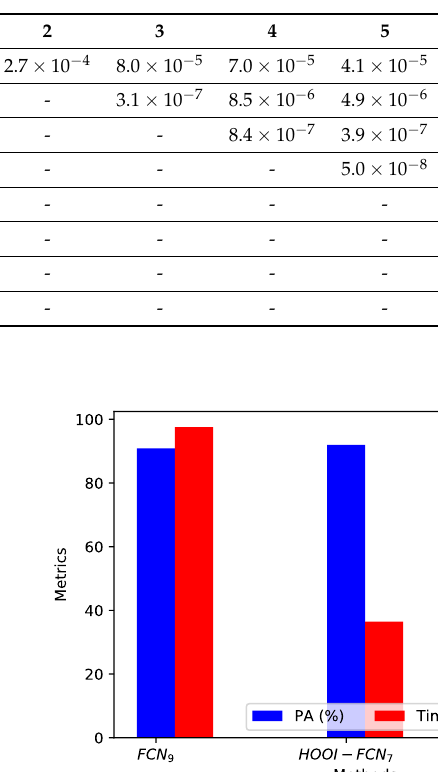
Table 4. Inner products of each tensor band with the others from one image of our dataset decomposed by HOOI.